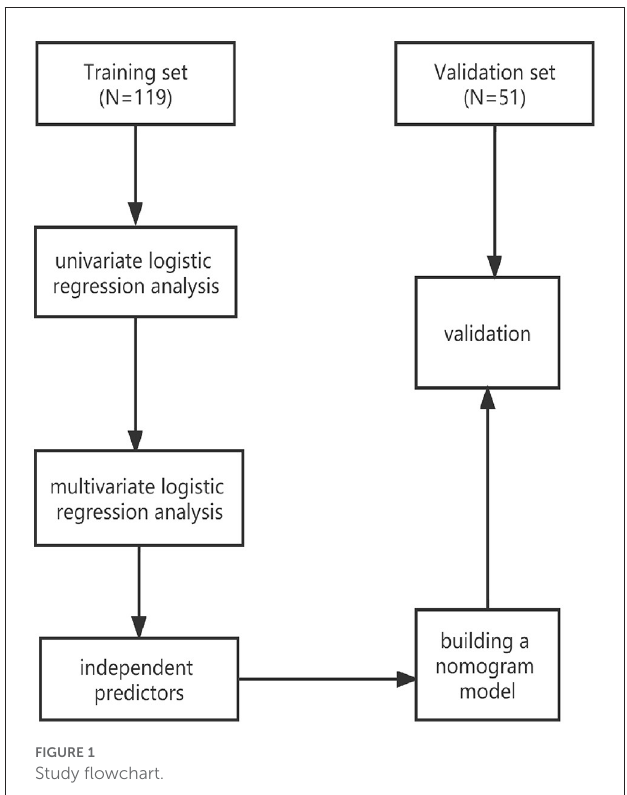
FIGURE1 Study flowchart.